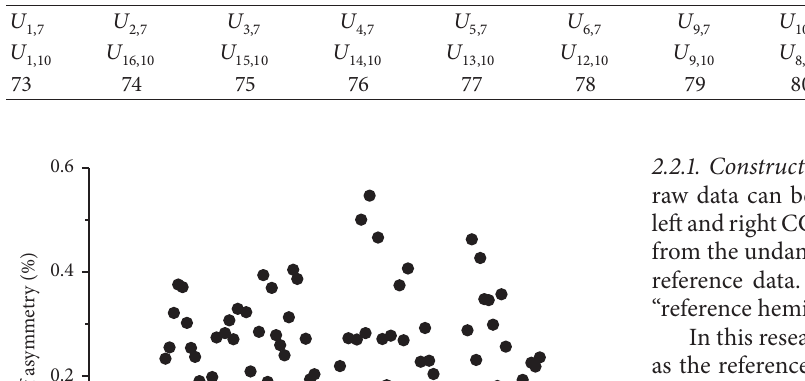
Table 8: SBVPs from electrode pair (7, 8) and electrode pair (11, 10).